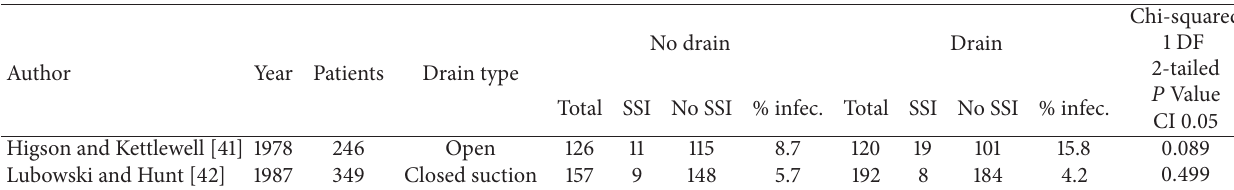
Table 2: Studies in which only the laparotomy data could not be extracted. Nonlaparotomy abdominal incisions were included.